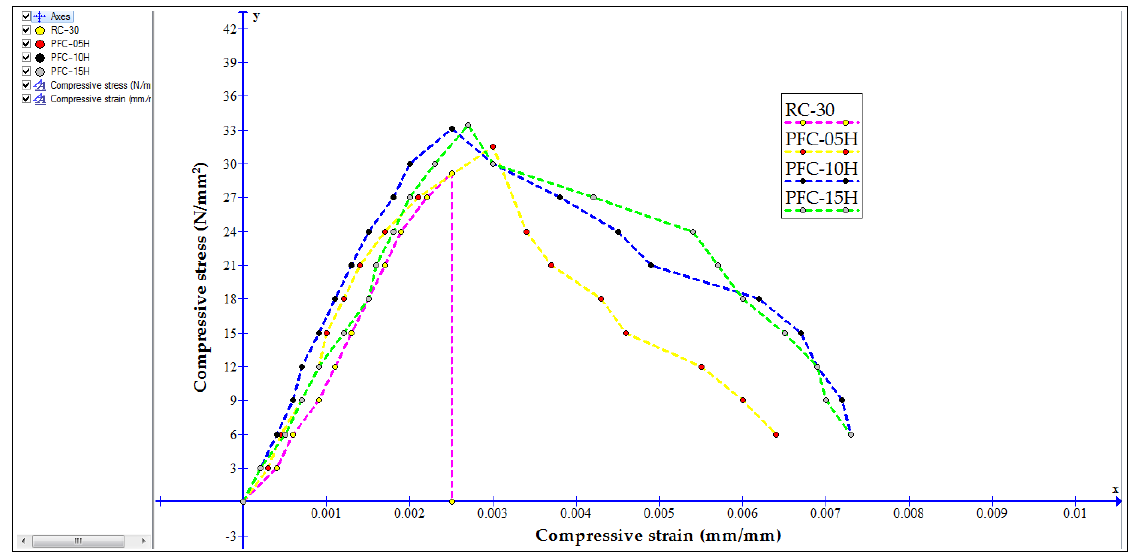
Figure 8. Stress-strain plot of various fiber concrete mixes in compression.